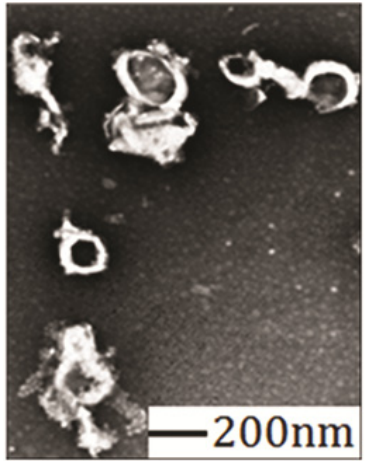
Figure 6. TEM image of Sal-LPNPs. Sal-LPNPs were general spherical with typical core-shell